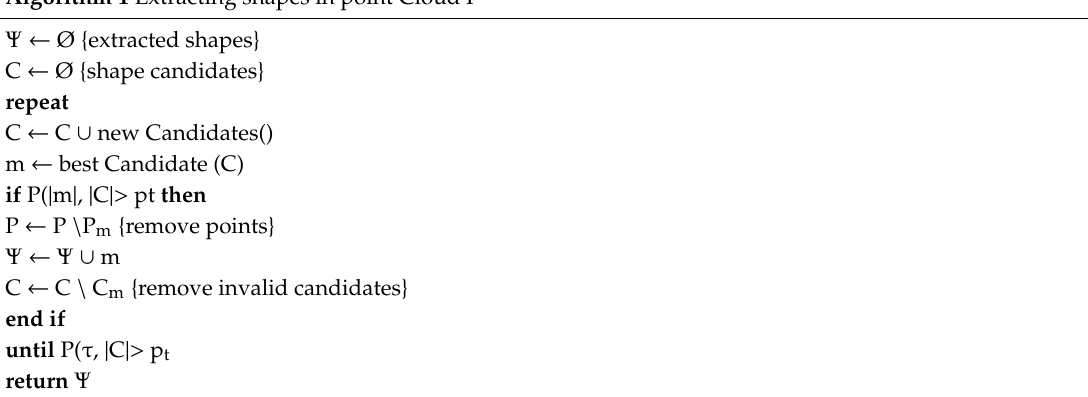
Algorithm 1 Extracting shapes in point Cloud